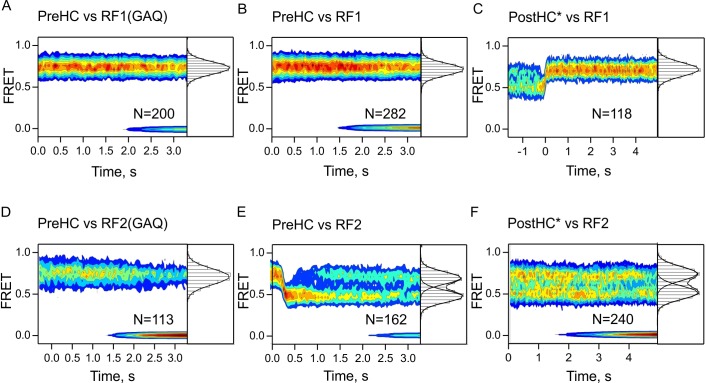
Time-resolved subunit rotation.FRET time courses measured with S6/L9-labeled termination complexes upon addition of low concentrations (100 nM) of RF1/RF1(GAQ) (A–C), or RF2/RF2(GAQ) (D–F). In (A,B,D) FRET signals did not change over time. In (C) traces are synchronized to the last R to N transition when the N state lasted significantly longer than the spontaneous rotation rate; this selection of particularly long-lived traces explains why photobleaching is not observed. In (E) traces are synchronized to the first N to R transition. FRET values are summarized in one-dimensional FRET histograms to the right of the contour plots. FRET values (mean ±sd) were calculated from three independent experiments and are 0.74 ± 0.01 (A), 0.75 ± 0.01 (B), 0.73 ± 0.01 (C), 0.75 ± 0.02 (D), 0.72 ± 0.02 and 0.49 ± 0.01 (E), 0.73 ± 0.02 and 0.51 ± 0. (F).